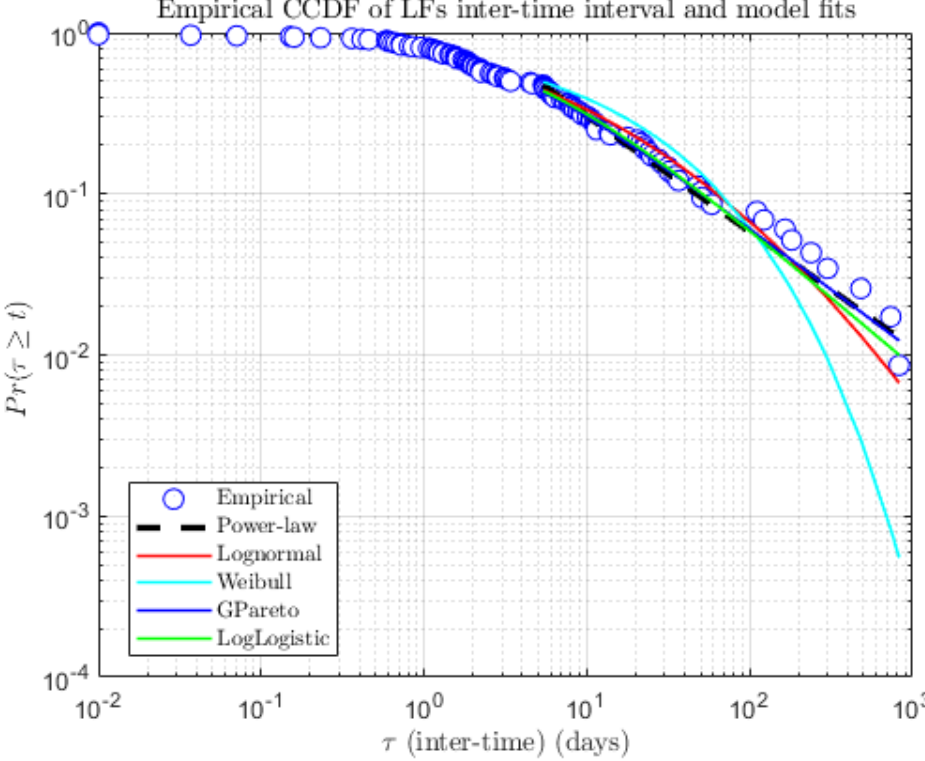
Figure 6. Log-log plot of the empirical complementary cumulative distribution function (CCDF) of lava fountain (LF) inter-event times and the five considered cumulative probability distribution models. Table 3. Negative log likelihood of compared models for the inter-event time dataset.